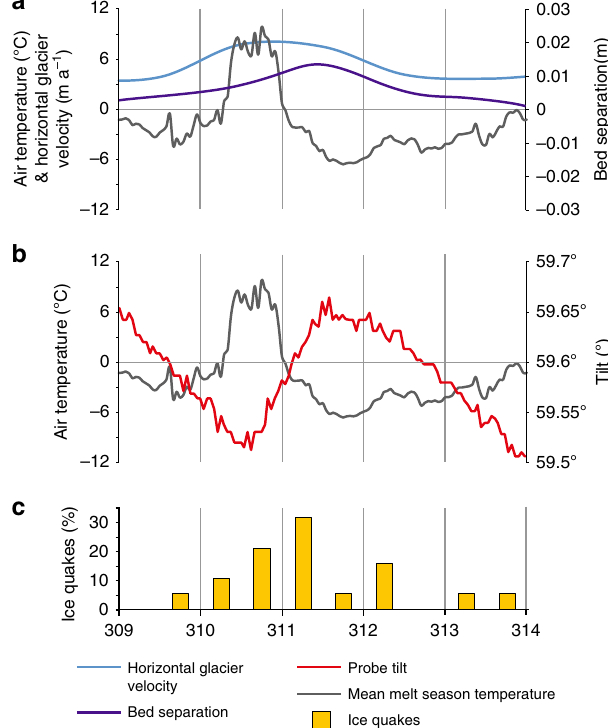
Fig. 6 Graphs showing typical winter multi-day melt event (day of year 309 – 314, 2012): a hourly air temperature, daily horizontal glacier velocity and daily bed separation (see text for details); b hourly air temperature and hourly probe tilt; c icequakes (plotted as percentage for each 12 h period over the 5 day cycle)